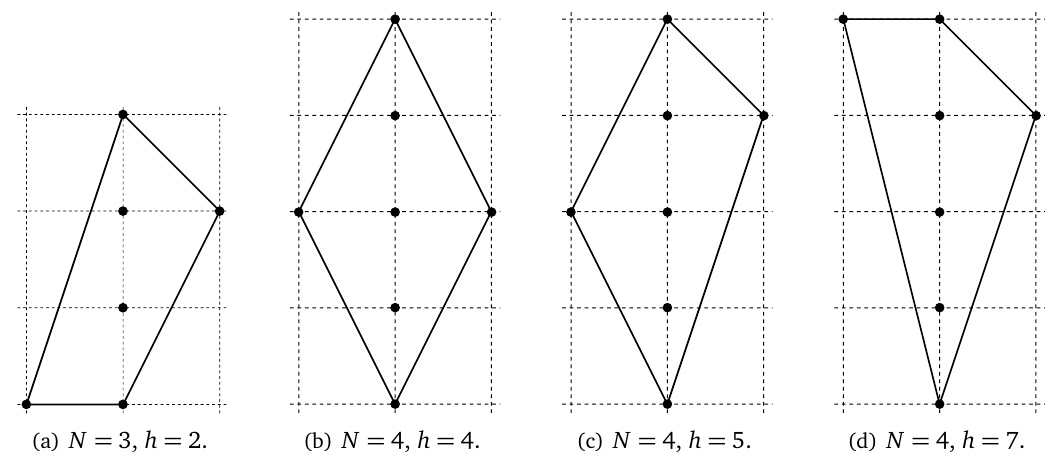
Figure 13: Examples of “ SU ( N ) corresponding gauge theories are SU ( 3 ) −